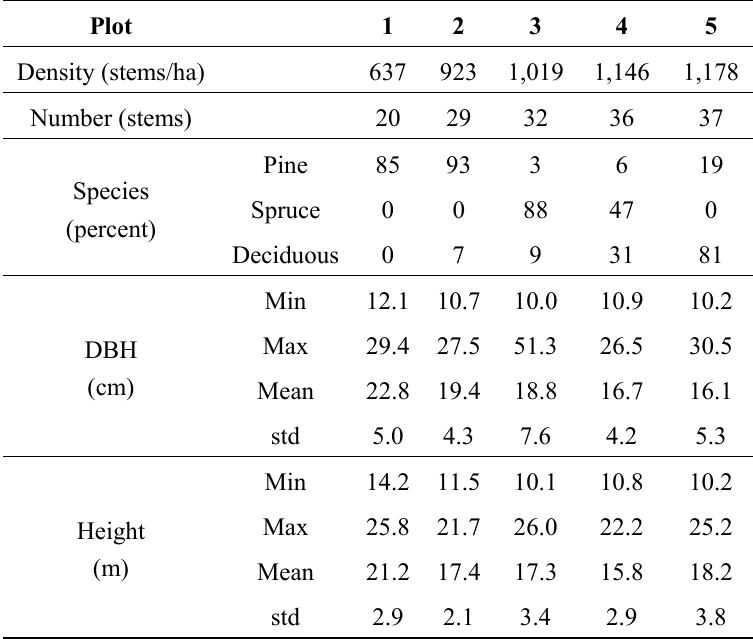
Table 1 . Statistical features of the study